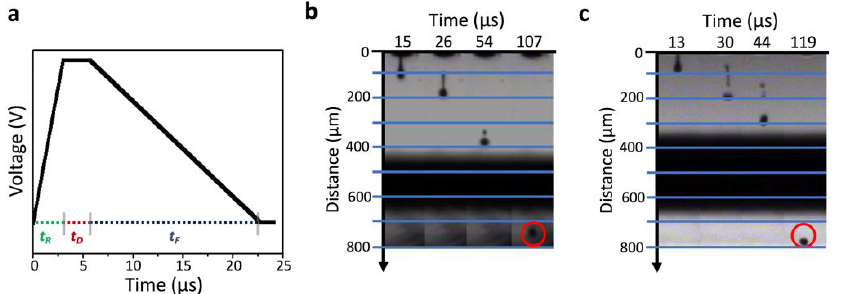
Figure 2. Inkjet printing P3HT and PCBM inks: ( a ) single-pulse waveform signal, composed of three phases of rise ( t R ), dwell ( t D ), and fall ( t F ); stroboscopic images showing droplet formation and satellite recoil at various acquisition times for P3HT ink ( b ) and PCBM ink ( c ) finally permitting us to print an almost spherical droplet in both cases (see the droplet within the red circle).